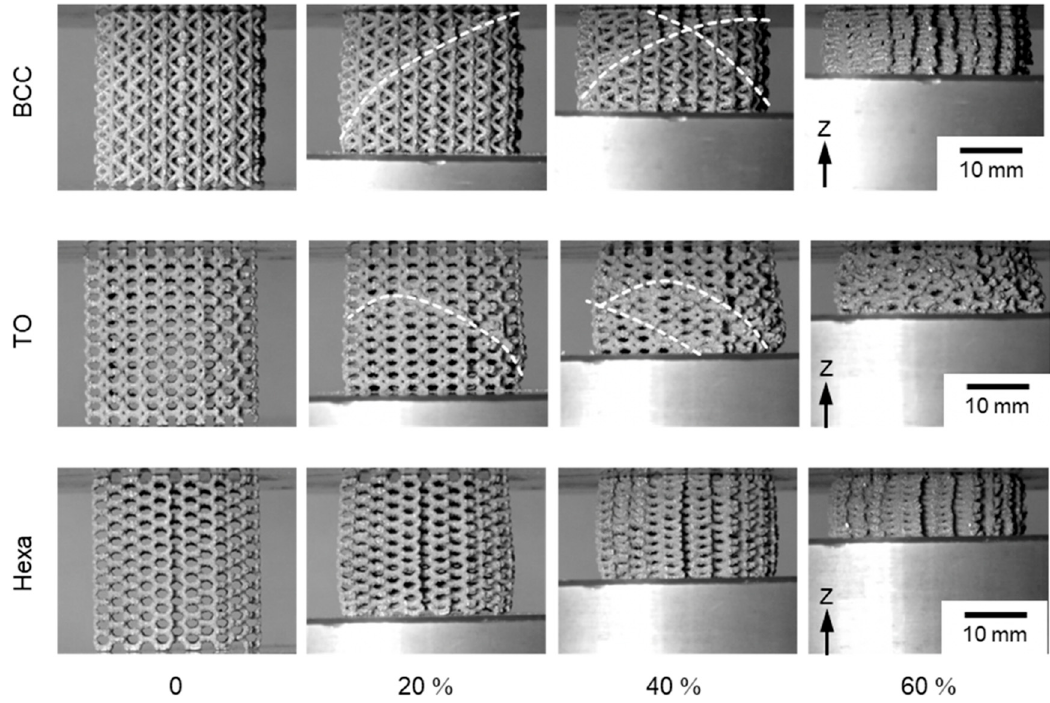
Figure 7. Photography images showing compression deformation behaviors of the lattice structures consisting of the BCC ( ρ * / ρ s = 0.16), TO ( ρ * / ρ s = 0.17), and Hexa ( ρ * / ρ s = 0.18) unit cells at 0%, 20%, 40%, and 60% nominal strains.